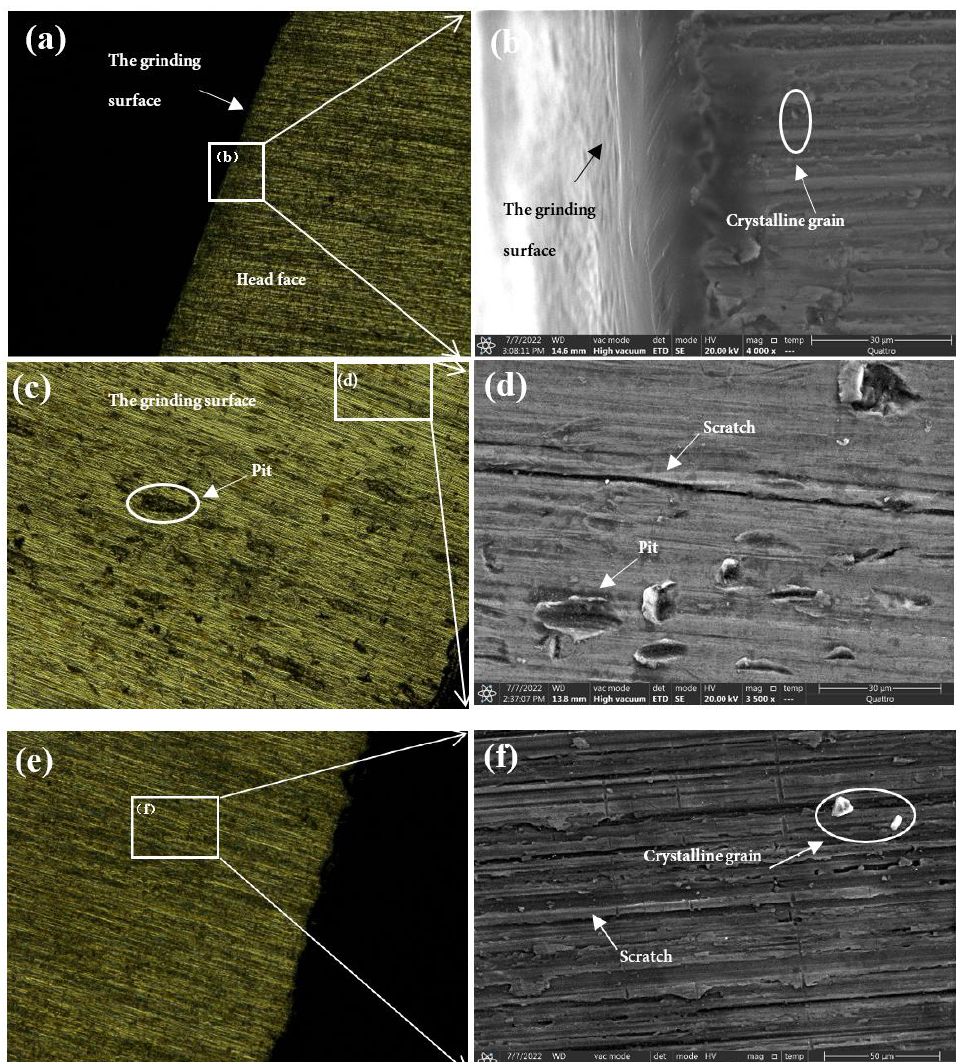
Figure 17. ( a , c , e ) are super depth-of-field shots, ( b , d , f ) are electron microscope shots; ( a , b ) are end surfaces, ( c – f ) are ground surfaces.